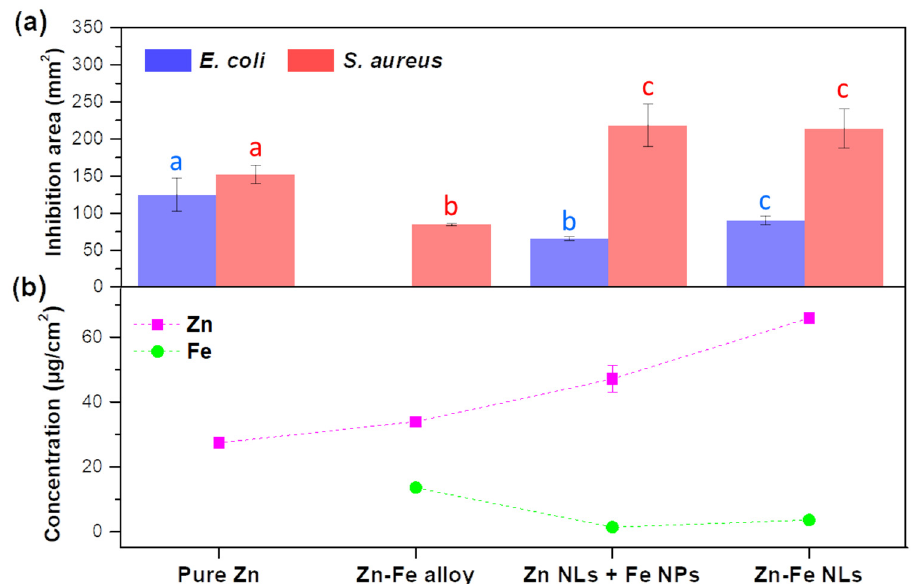
Figure 8. ( a ) Inhibition area of the coating systems, pure Zn, Zn-Fe alloy, Zn NLs + Fe NPs, and Zn-Fe NLs, against E. coli and S. aureus (different letters within each bacterium mean values were statistically different at 95% confidence level); ( b ) Zn and Fe concentrations in the different coatings as obtained by ICP-OES.